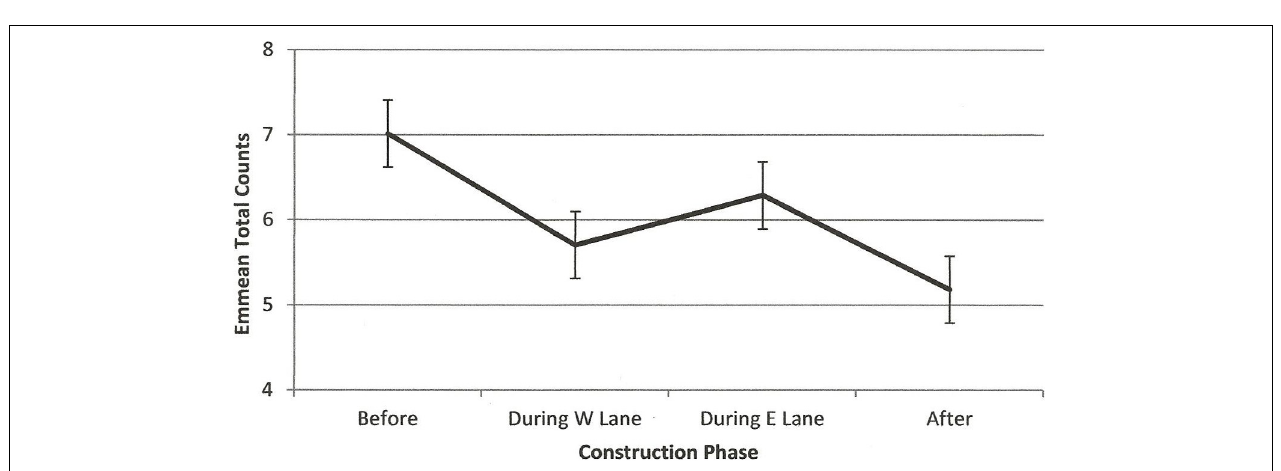
FIGURE 10 | Estimated marginal means of total counts of dolphins in the construction zone before, during, and after construction.